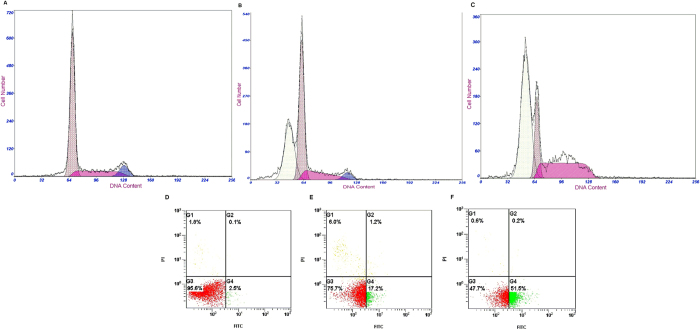
Annexin V-FITC flow cytometry.Cell cycle progression (A–C) and annexin V-FITC/PI staining was monitored in HepG2 cells following 24 h treatment with compound Ik at concentrations corresponding to their IC50 or 2 × IC50 (E and F). Representative dot plots of three independent experiments are given, presenting intact cells at lower-left quadrant, FITC(−)/PI(−); early apoptotic cells at lower-right quadrant, FITC(+)PI(−); late apoptotic or necrotic cells at upper-right quadrant, FITC(+)/PI(+); necrotic cells at upper-left quadrant, FITC(−)/PI(+).